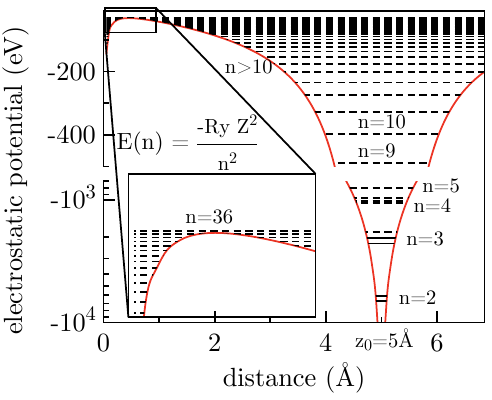
Figure 2. (Color online) Electrostatic potential of a Xe 30 + ion along the ion-surface connection line normal to the surface. Binding energies for occupied levels (straight lines) are given from Hartree–Fock calculations [32] and empty states (broken lines) from Rydberg scaling of levels for heavy atoms. Level shifts due to image charge are here neglected for clarity.